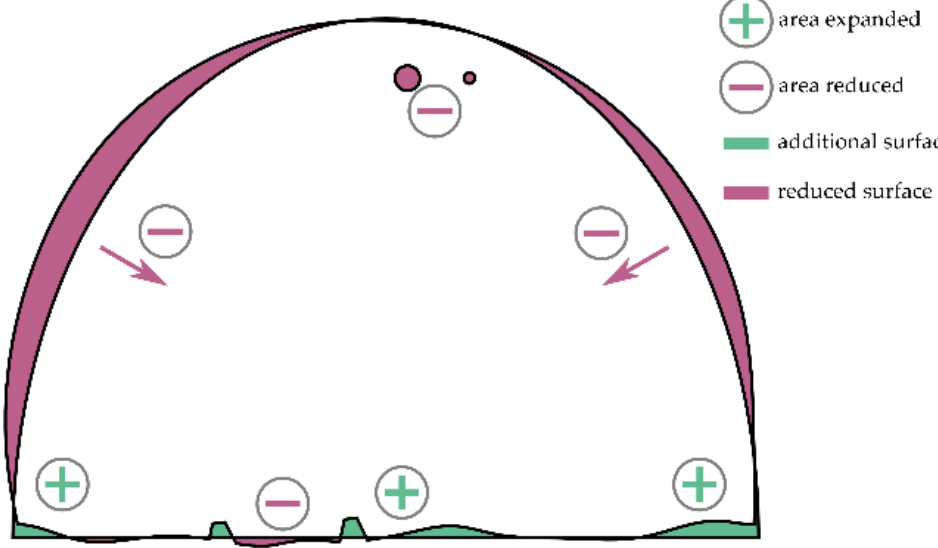
Figure 13. Differences in cross-sections between reference method and approximation by a semi- ellipse; cross-section 1.2.